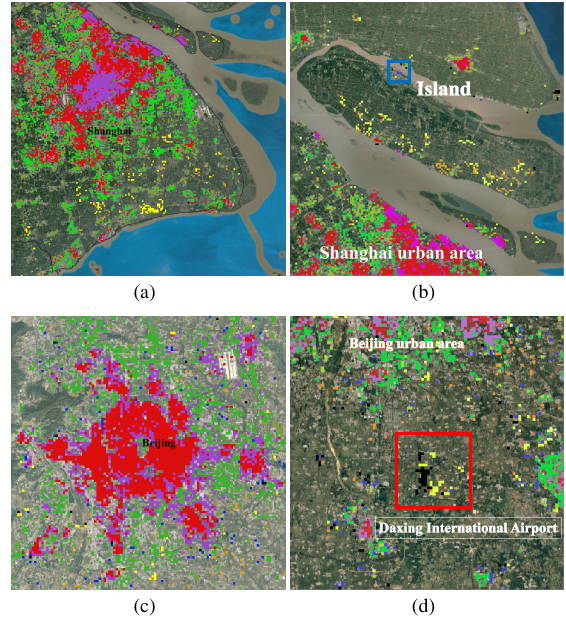
Figure 4. Spatial location of changes inside and outside urban areas: (a) the 8-component clustering map of the main urban area of Shanghai; (b) small settlements in the island in Yangtze River Delta; (c) the main urban area of Beijing; (d) small settlements far from it (the black patch inside the red rectangle is the construction site of the new Beijing Daxing International